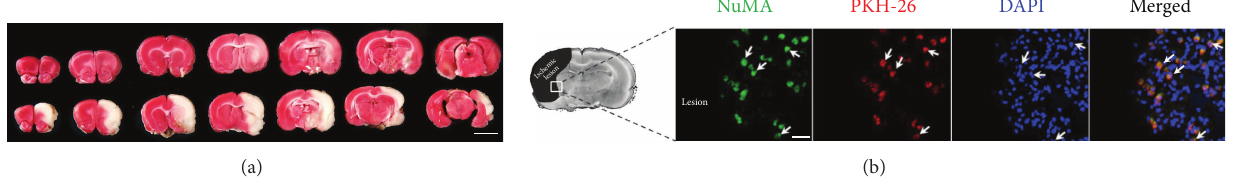
Figure 1: 2,3,5-Triphenyltetrazolium chloride (TTC) staining and hBM-MSC staining with anti-NuMA antibody, PKH-26, and DAPI. (a) TTC-stained coronal brain sections of control (upper panel) and 5 days after MCAo (bottom panel). Scale bar = 5 mm. (b) hBM-MSCs labelled 5 days after MCAo. The localization of hBM-MSCs in the ischemic region was identified by NuMA (green), PKH-26 (red), and DAPI (blue); white arrows indicate double-positive cell. Scale bar = 20 𝜇 m.